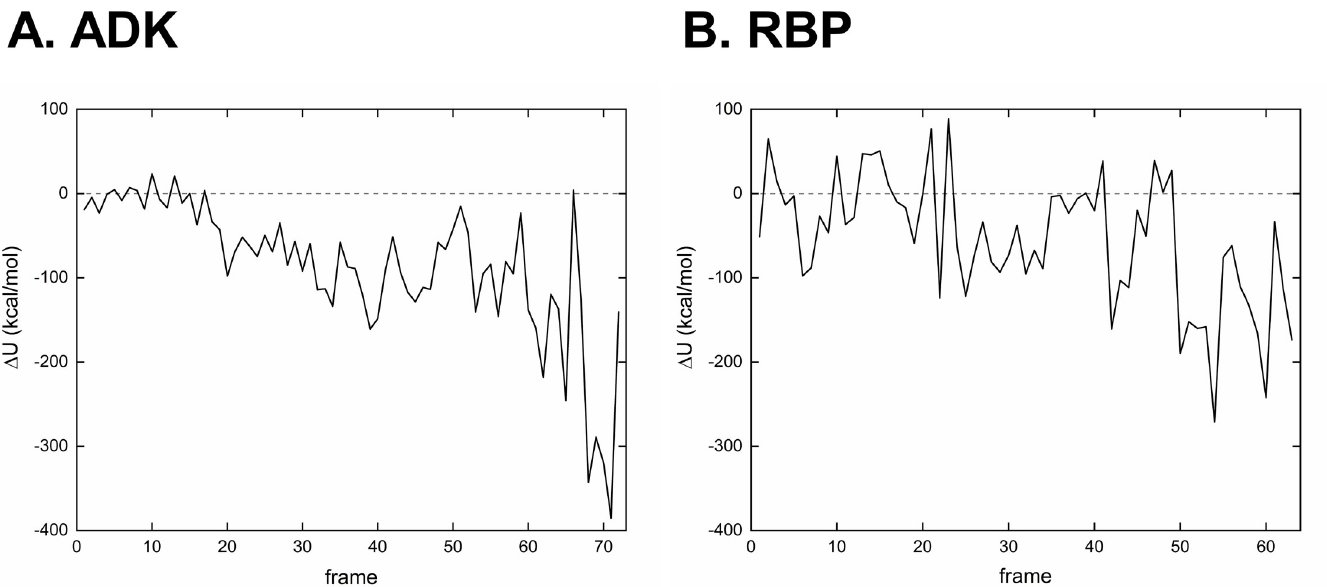
Fig 6. The difference between potential energies of ICONGENI and NGENI pathways for (A) ADK and (B) RBP. The difference of the potential energy Δ U = U ICONGENI − U NGENI . Before calculating the potential energies, all simulated intermediate structures were transformed into all atom models based on corresponding reference structures (4AKE:A (1BA2:A) for ADK (RBP)) and were energy minimized using CHARMM36m force field for 500 steps of conjugate gradient.